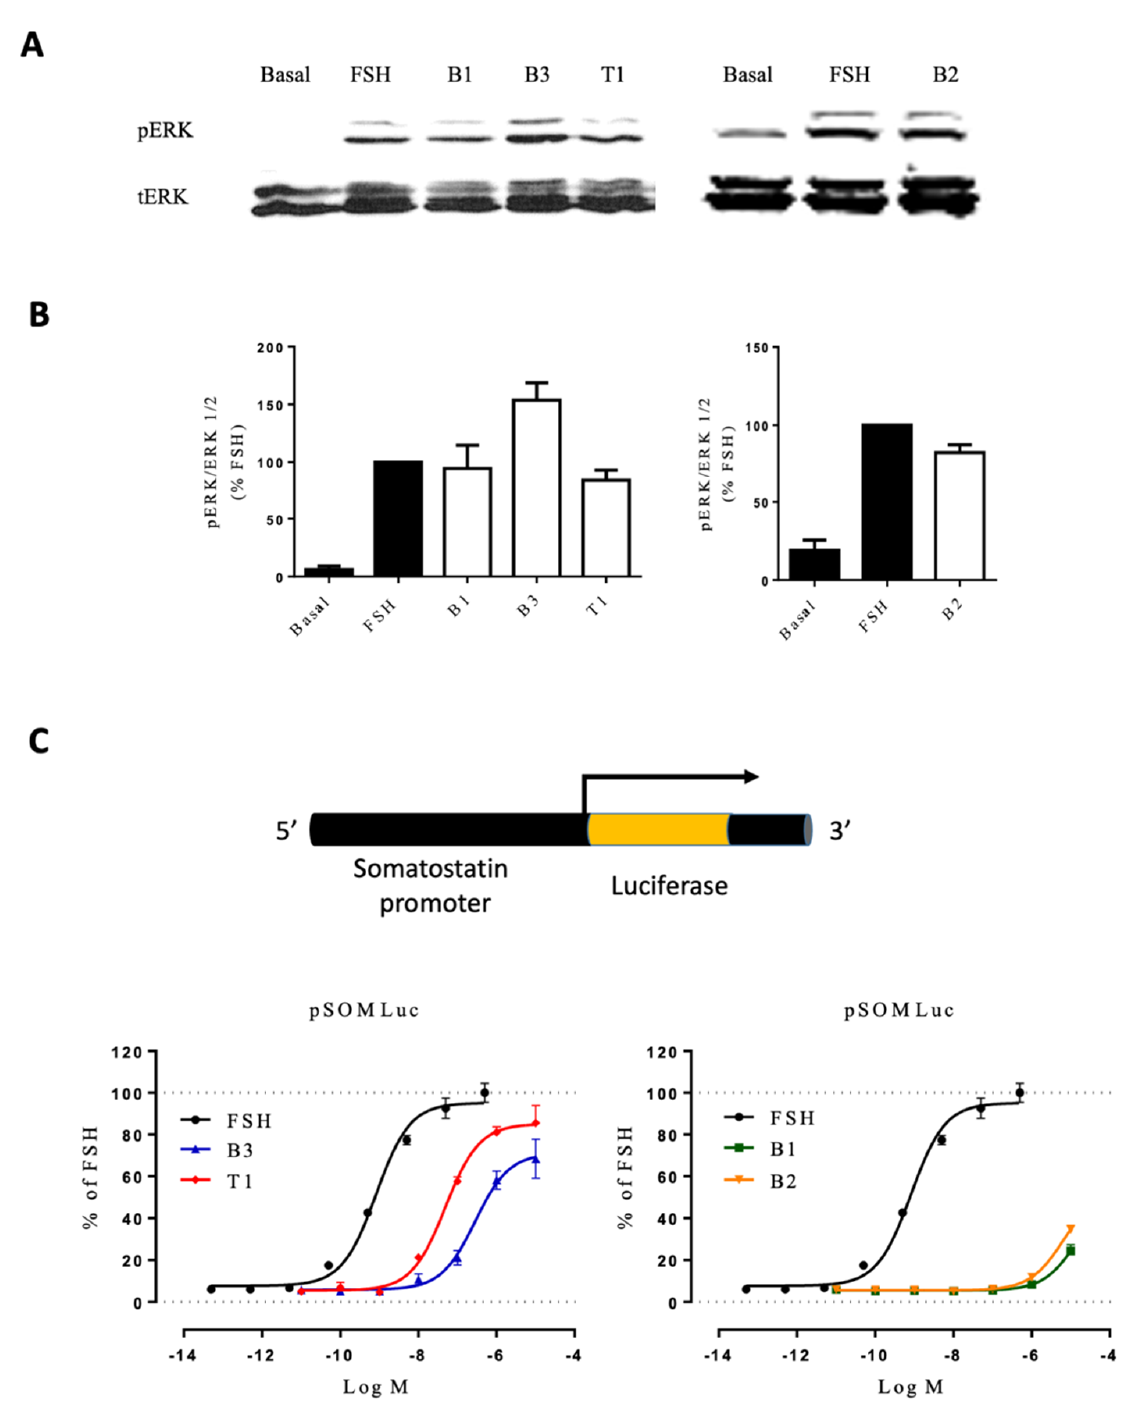
Figure 5. Activity of FSH vs. LMW ligands on downstream signaling. ( A ) HEK293 cells expressing the FSHR were stimulated with EC 80 concentration of FSH or LMW ligands for 5 min. ERK phosphorylation was analyzed by western blotting. ( B ) Images were quantified and represented as normalized phosphorylated ERK/ERK1/2 values. ( C ) HEK293 co-expressing the FSHR and CRE-luciferase reporter gene were stimulated with increasing concentrations of FSH (10 − 12.5 to 10 − 6.5 M) or LMW ligands (10 − 10 to 10 − 4 M). Luciferase activities were recorded 6 h after stimulation, and signals were normalized over FSH maximal response. Values were plotted and fitted by non-linear regression. Data are represented as mean ± SEM from at least six independent experiments.